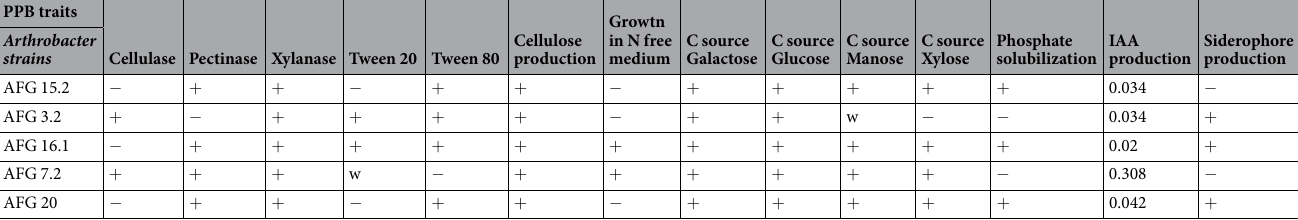
Table 3. Ecological, plant growth promoting related enzymatic activities and indolacetic acid production in selected Arthrobacter strains. ( + ) positive, ( − ) negative and (w) weak. Indolacetic acid production is expressed in µ g ml − 1